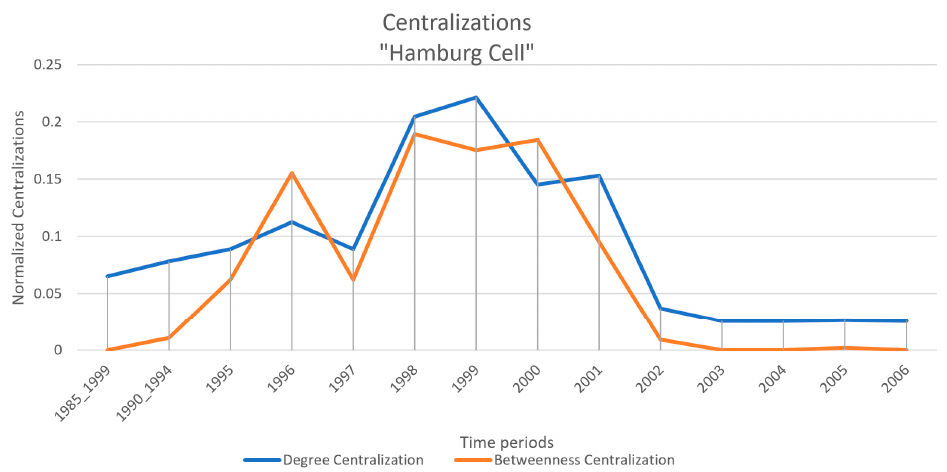
Figure 10. Temporal development of degree and betweenness centralizations for the “Hamburg Cell”. Both indices fluctuate, with three maximum values. The first maximum appears in 1996 for both centralizations; the second maximum appears in 1997 for betweenness centralization and one year later for degree centralization, and the third maximum appears in 2000 for betweenness centralization and one year later for degree centralization.